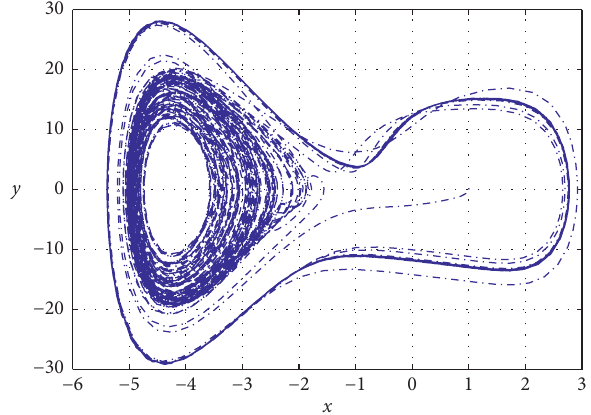
, μ ) � (− 0 . 001 , 1 2 , y ) � ( 0 . 1 , 0 . 2 ) . 0 0